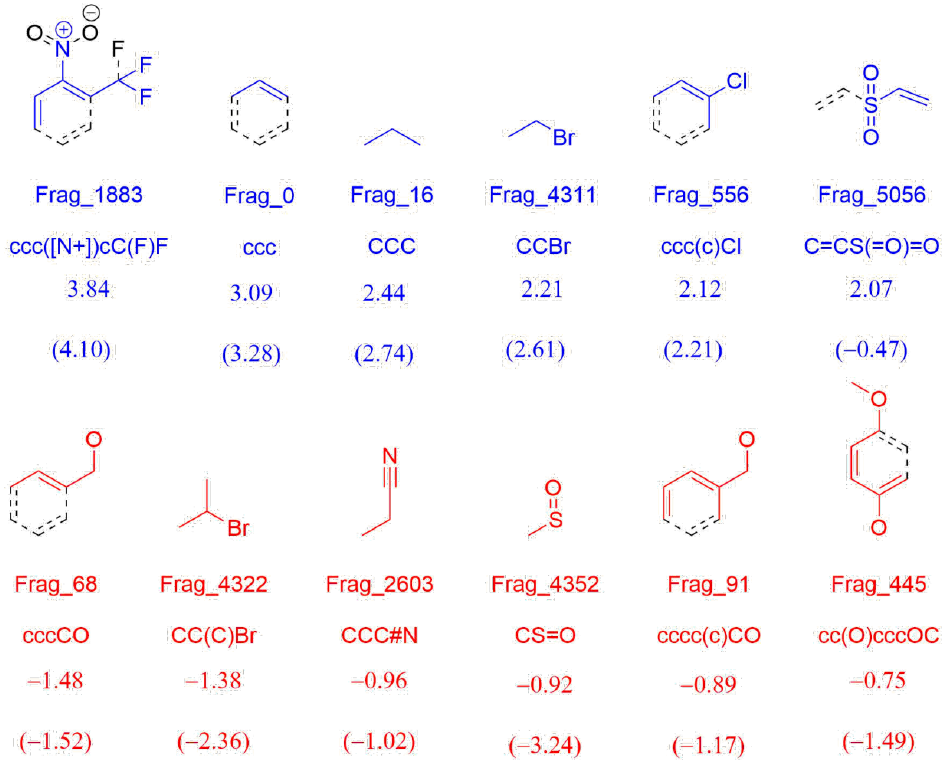
Figure 6. Main molecular fragments (MFs) retrieved by the LASSO model for biological activity (pIGC50) against T. pyriform . The red-colored fragments have negative values and increase the toxicity. The blue MFs have positive values and decrease toxicity. Below, each MF there is its name, SMILES notation, LASSO coefficient, and the multilinear coefficient, in